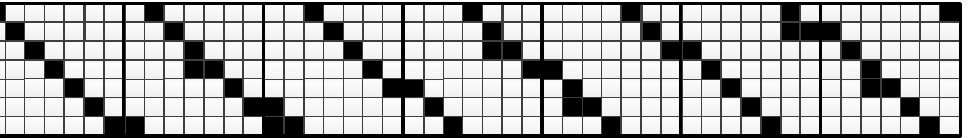
Figure 3. The erasure matrix in Liberation when k is 7 and w is 7.